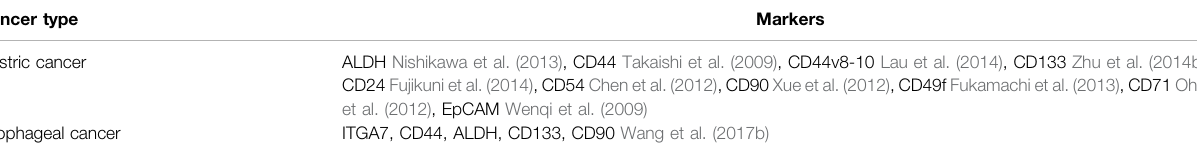
TABLE 2 | Cancer stem cell markers in gastroesophageal cancers. Cancer type Markers